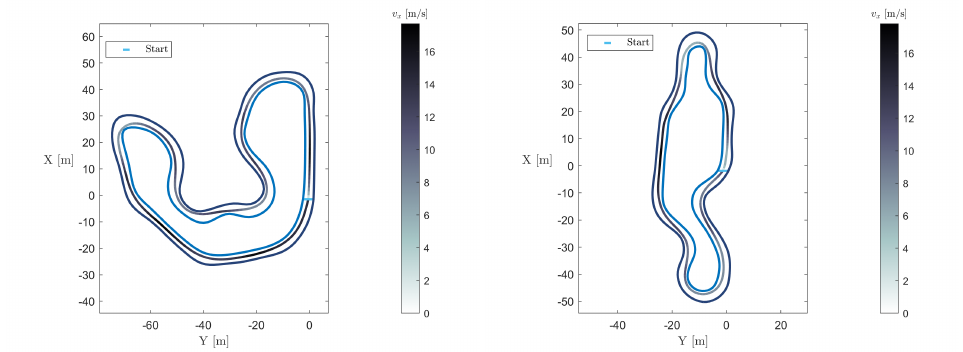
Figure 10. FSG ( left ) and FSI ( right ) reference trajectory. Table 2. Planning parameters.